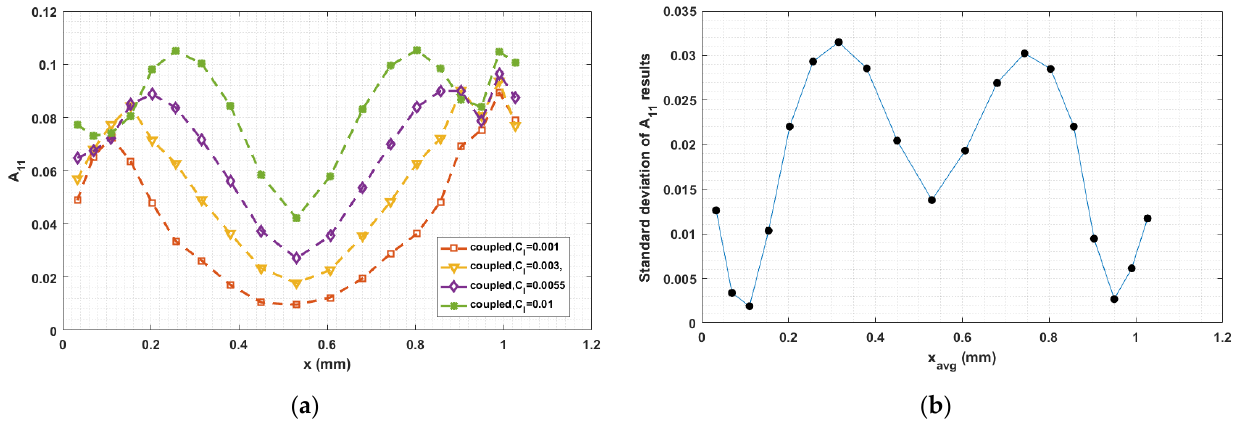
Figure 19. ( a ) Fiber orientation tensor component A 11 at nozzle exit; ( b ) standard deviation of the parametric study resulted A 11 versus the averaged x locations.